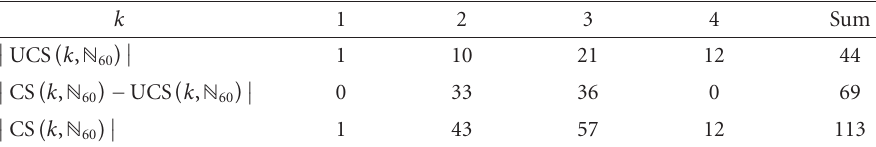
Table 3.2. Distribution of | CS( N 60 ) |